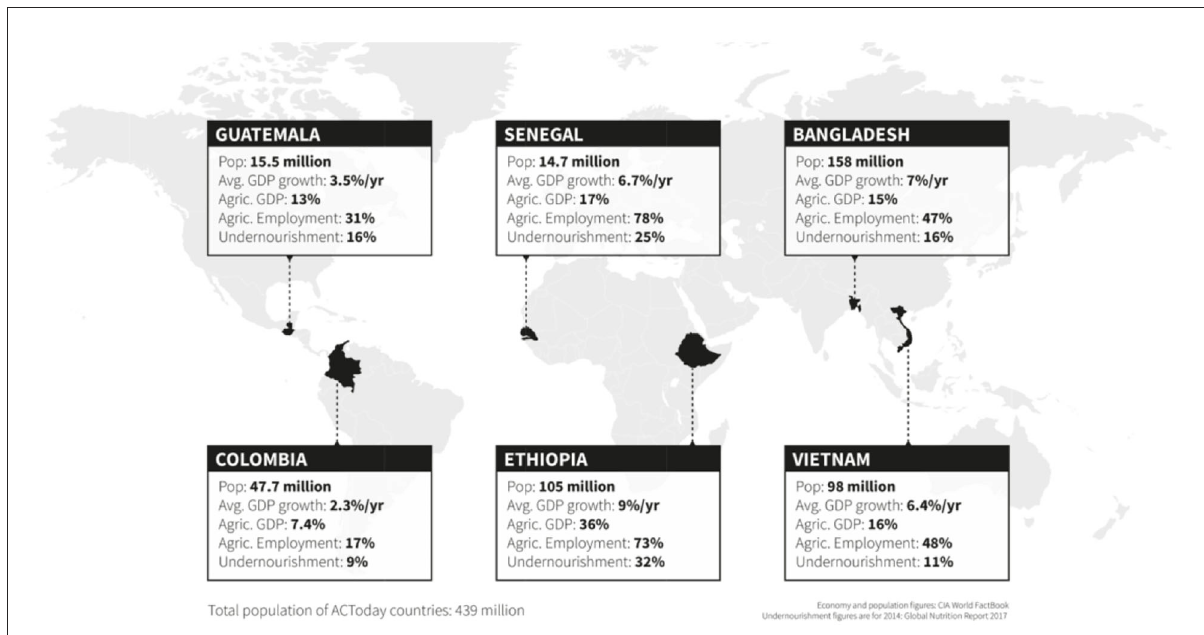
FIGURE1 ACToday approach countries of implementation. The ACToday approach was intentionally mplemented in six agriculture-dependent countries with varying institutional arrangements, histories, cultures, and enabling environments across the world, in order to gain insights and lessons on how climate services might be best implemented in different